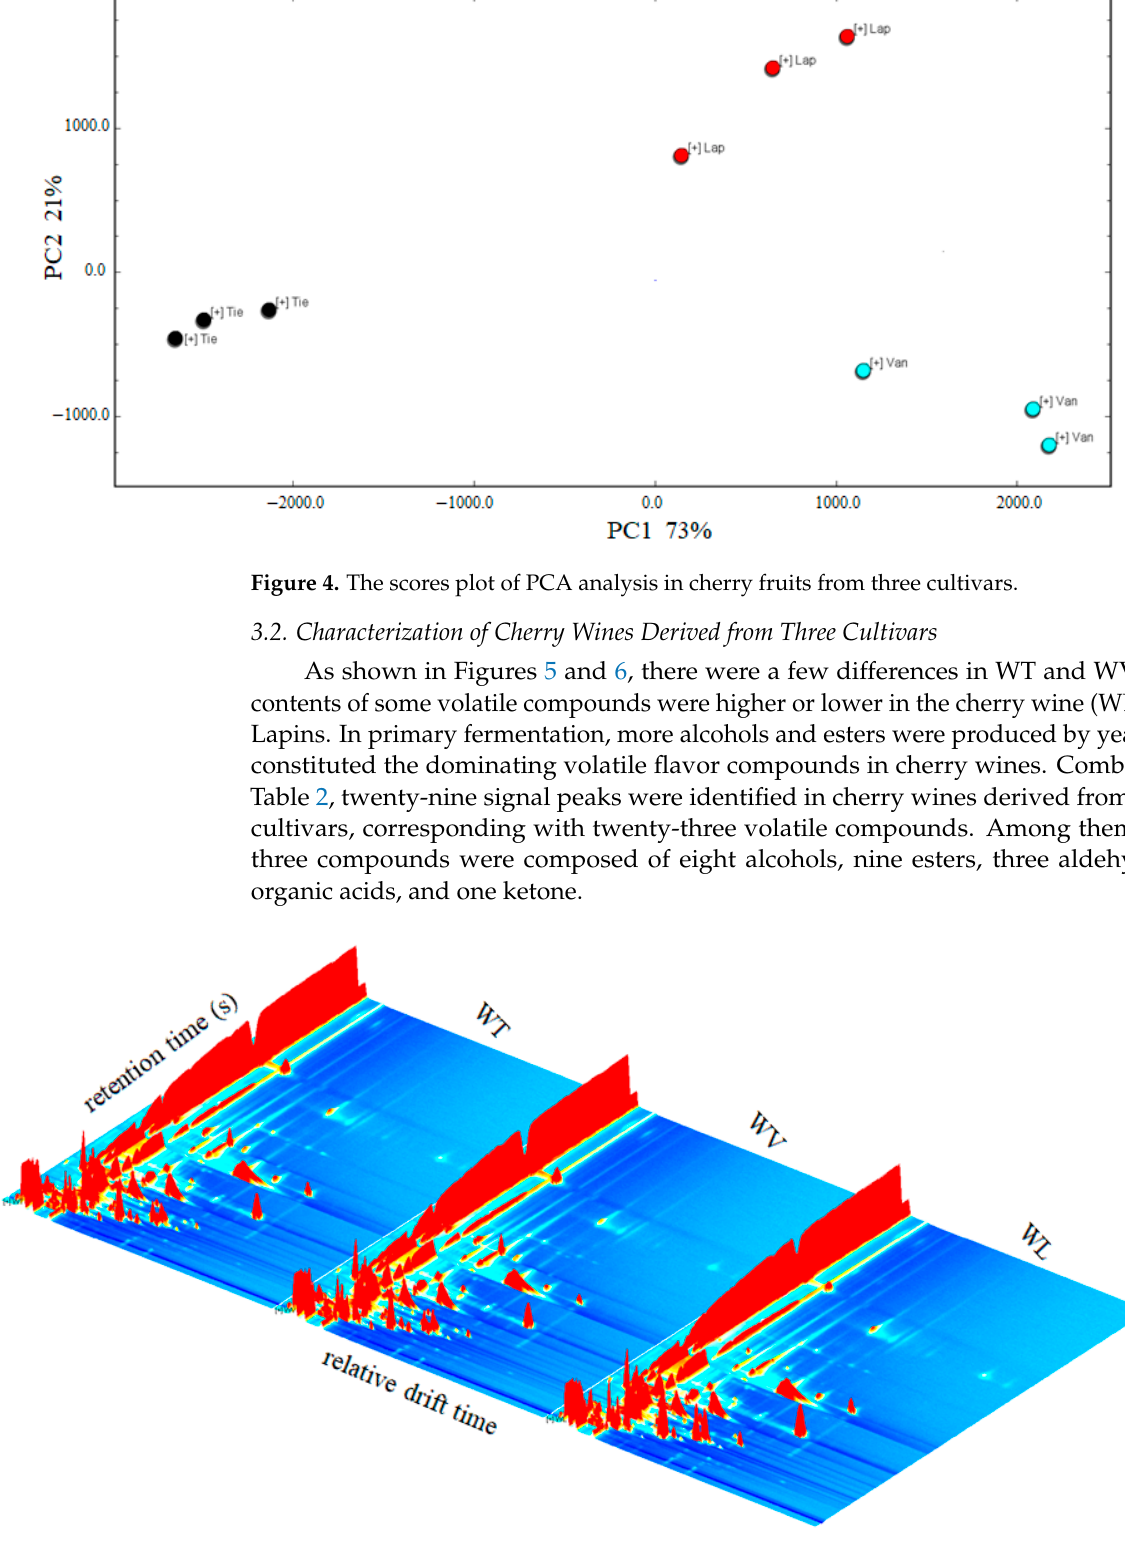
Figure 5. Differences in the three-dimensional (3D)-topographic of volatile compounds in cherry wines derived from three cultivars (WT: cherry wine from cultivar Tieton; WV: cherry wine from cultivar Van; WL: cherry wine from cultivar Lapins).